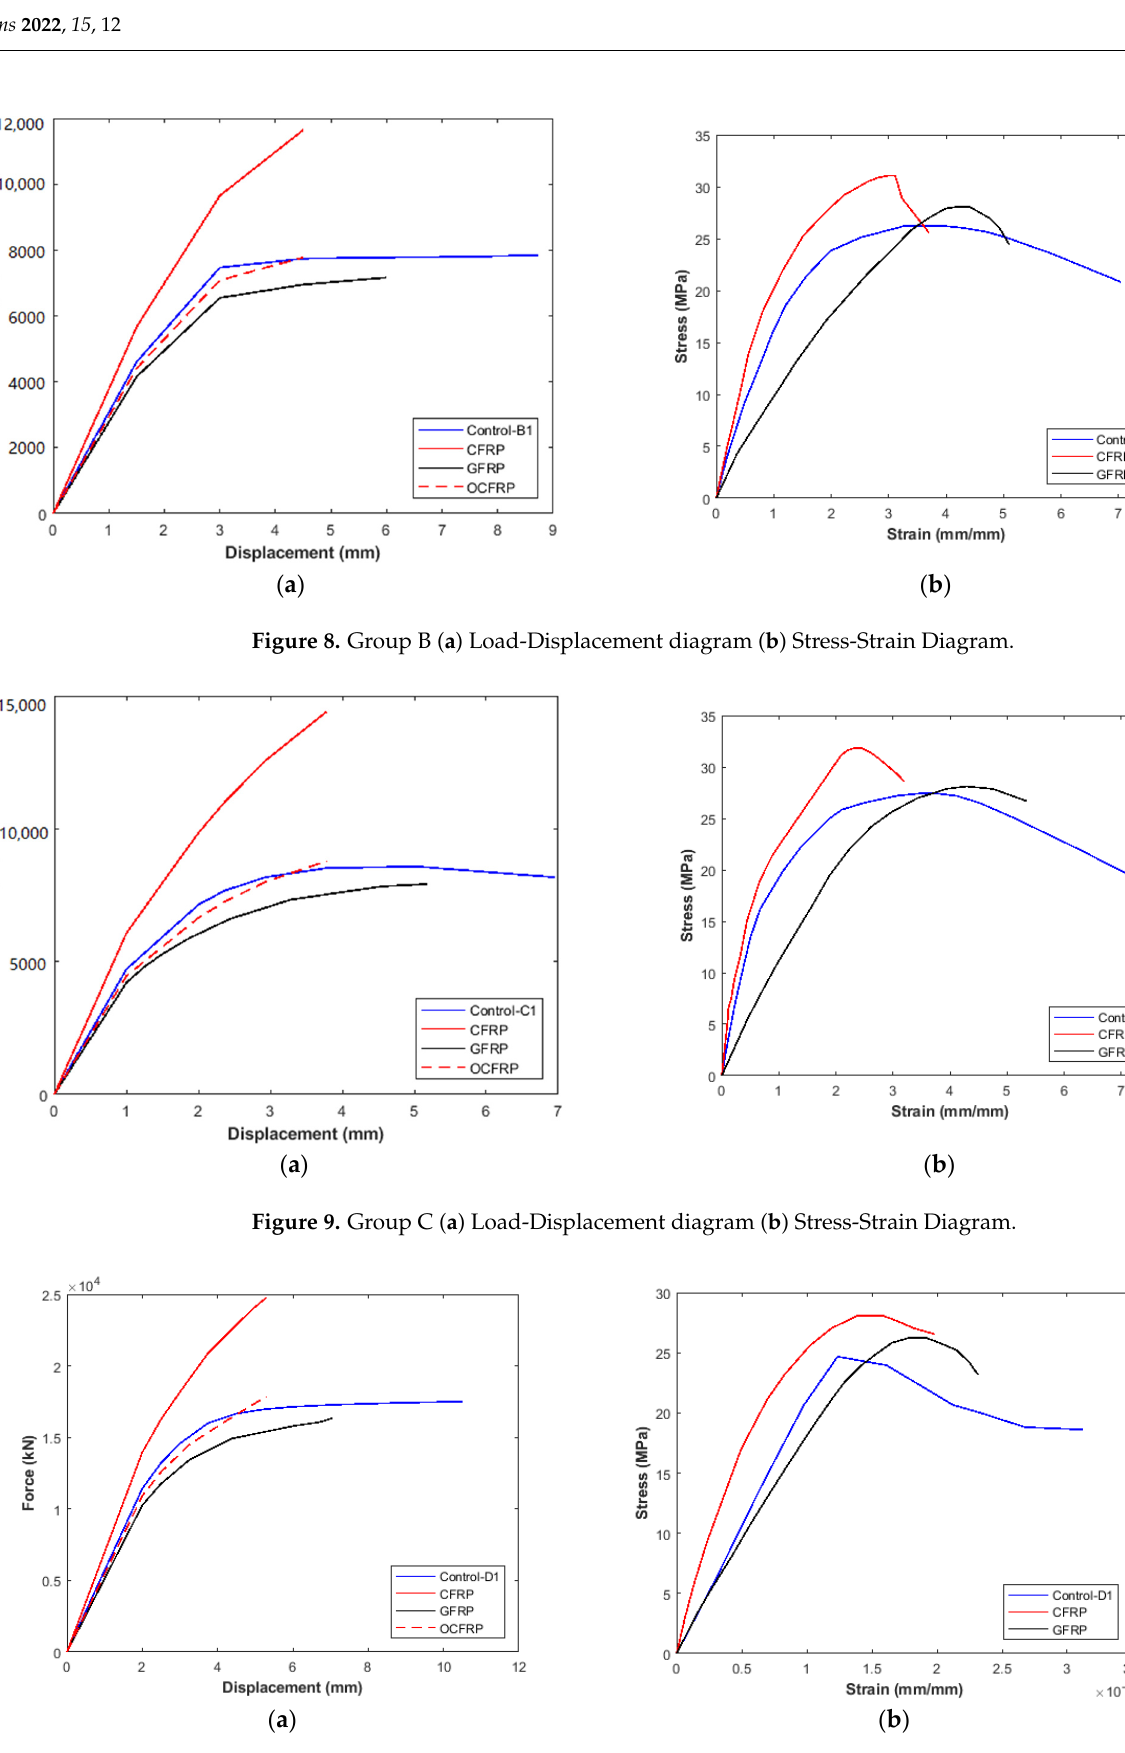
Figure 7. Group A ( a ) Load-Displacement diagram ( b ) Stress-Strain Diagram.